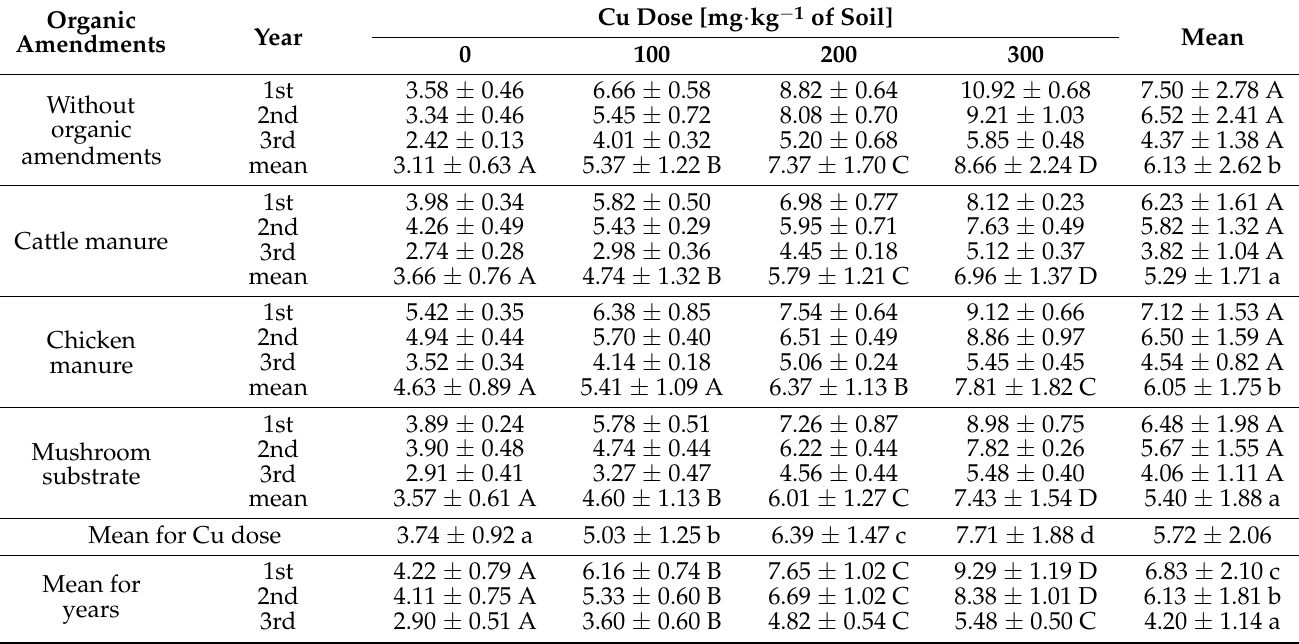
Table 3. Copper content in cocksfoot, mg Cu · kg − 1 DM (mean ±